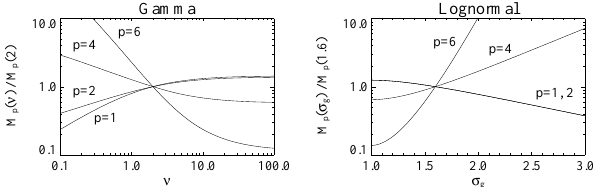
Figure 1. Relationship between the moments of the order p = 1 , 2 , 4 and 6, and the shape parameter for the gamma function (left) and the lognormal function (right). Each moment is normalized by the value corresponding to ν = 2 for the gamma function and σ g = 1 . 6 for the lognormal